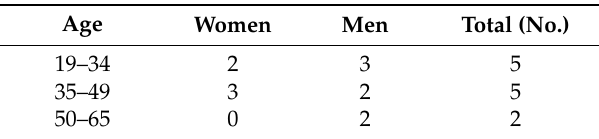
The demolished Masrah Al Salam context interview participants’ characteristics. Source: F.